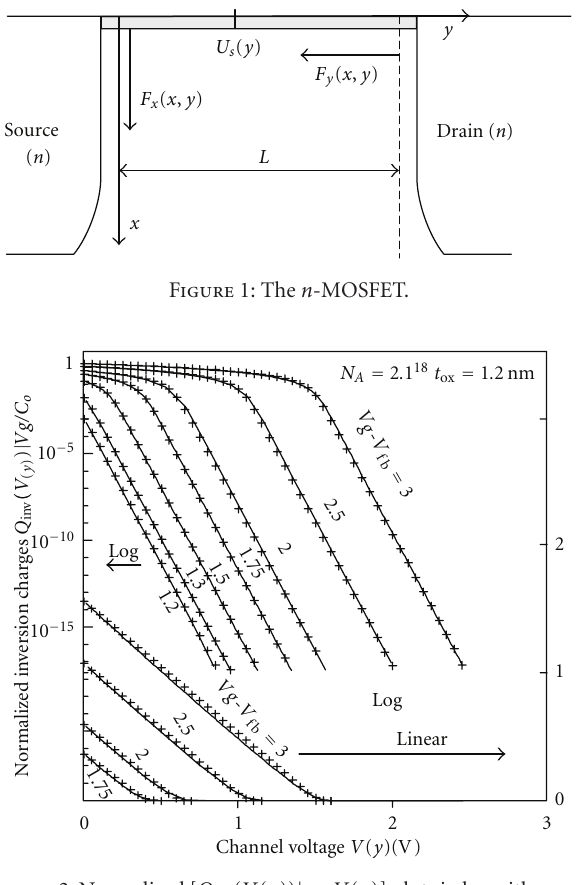
Figure 2: Normalized [ Q inv ( V ( y )) | linear scales. ( − ) (11), (+) (17).